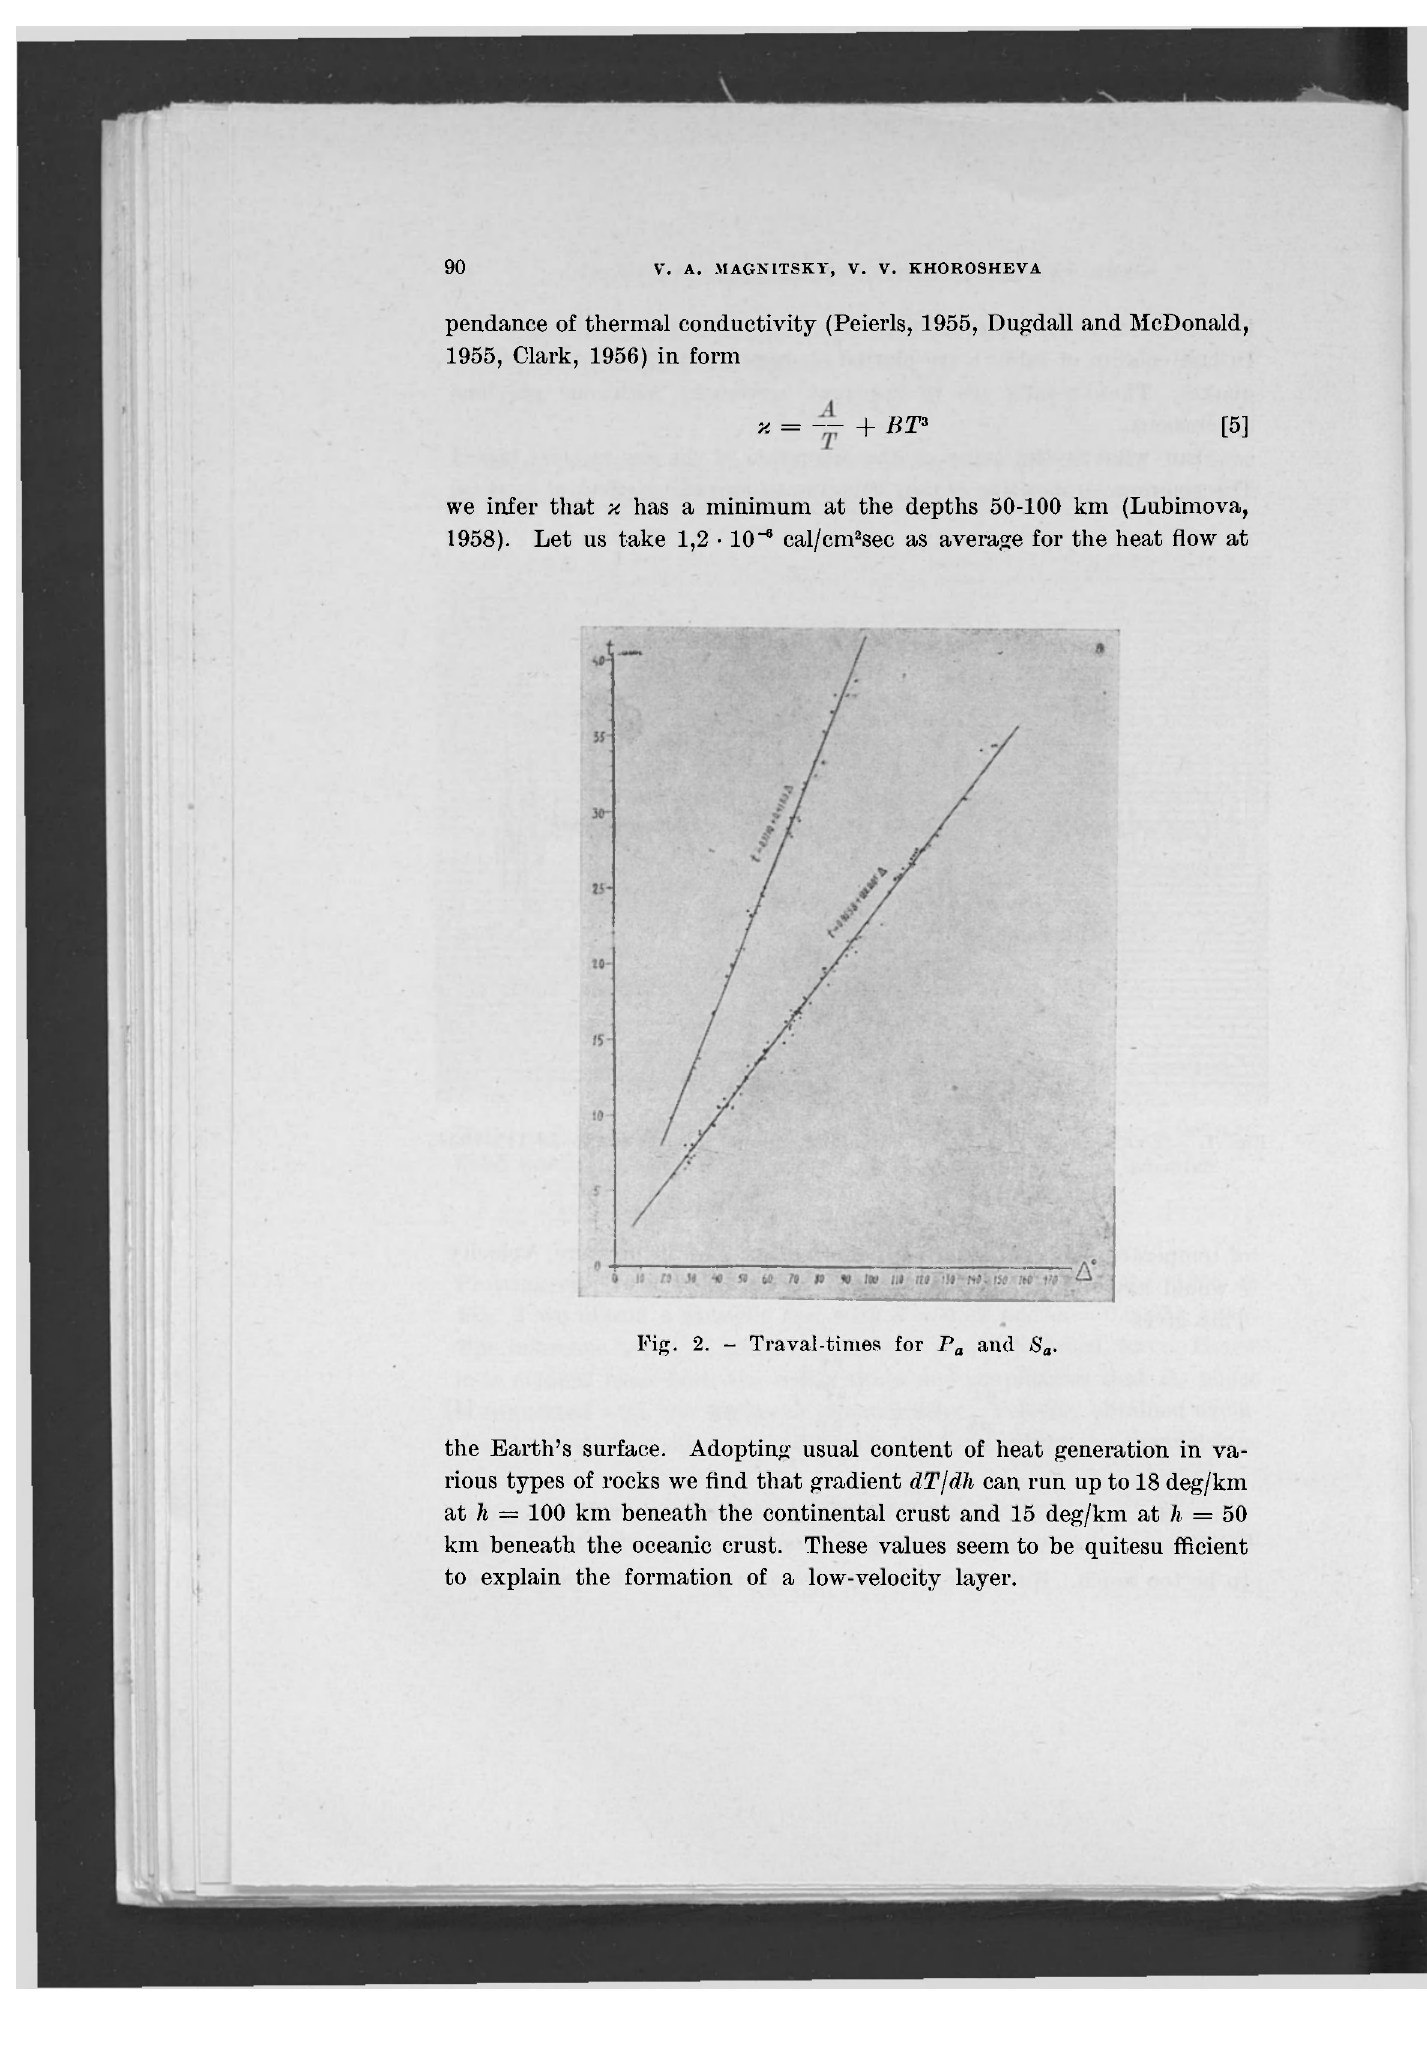
Fig. 2. - Traval-times for P a and S a